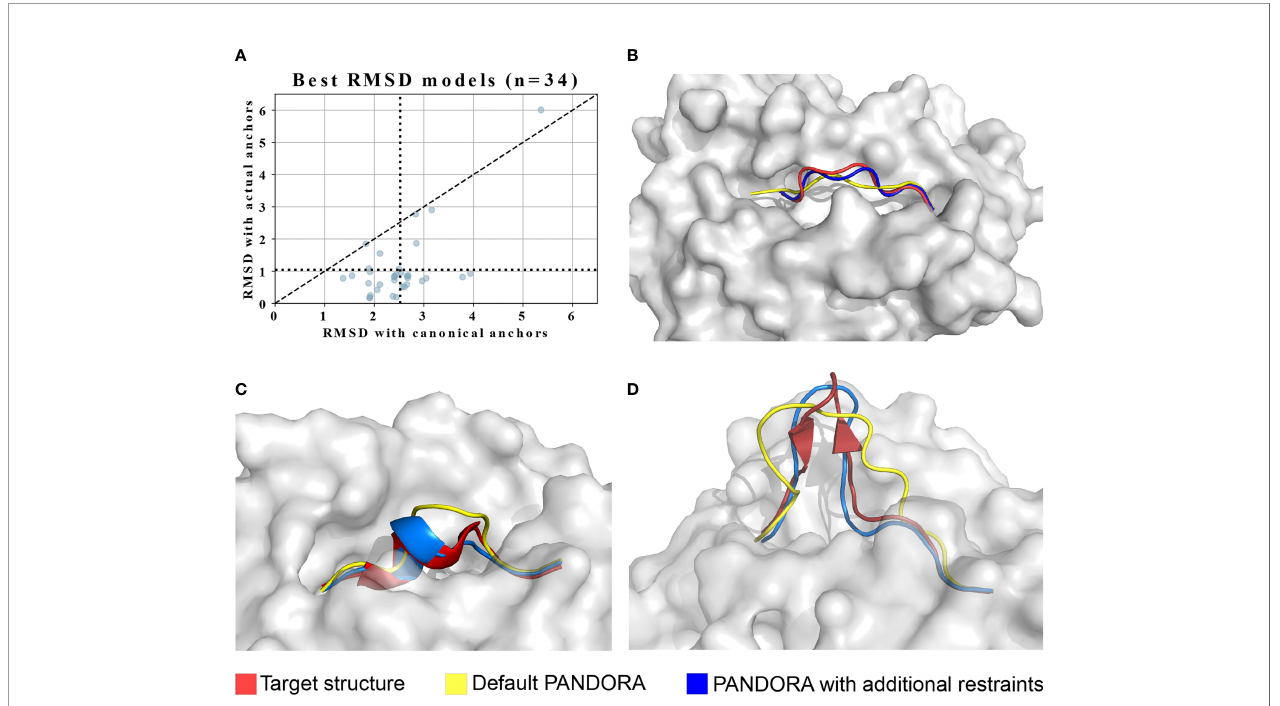
FIGURE 4 | PANDORA ’ s case studies on with non-canonical cases. The images are oriented to present the most representative view of the difference between models and target. (A) PANDORA produced better models than using canonical anchor positions in terms of backbone L-RMSD of cases. (B) A typical case (target PDB ID: 1DUY, template PDB ID: 1AO7 in Red, peptide=LFGYPVYV) with non-canonical anchor positions Blue with (actual anchors: P1 and P9( W ). (C) Case study on the 10-mer from PDB structure 3BEW (Red). L-RMSD with default settings: 2.02 Å (Yellow); L-RMSD using secondary structure restraints: 0.80 Å (Blue). (D) Case study on the 15-mer from PDB structure 4U6Y (Red). L-RMSD with default settings: 3.32 Å (Yellow); L-RMSD using secondary structure restraints: 1.50 Å